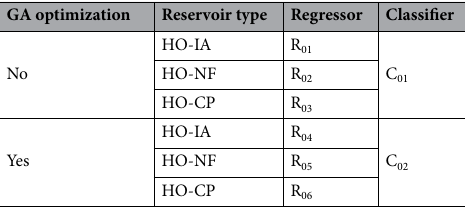
Table 4. Details of trained classifier and regressor